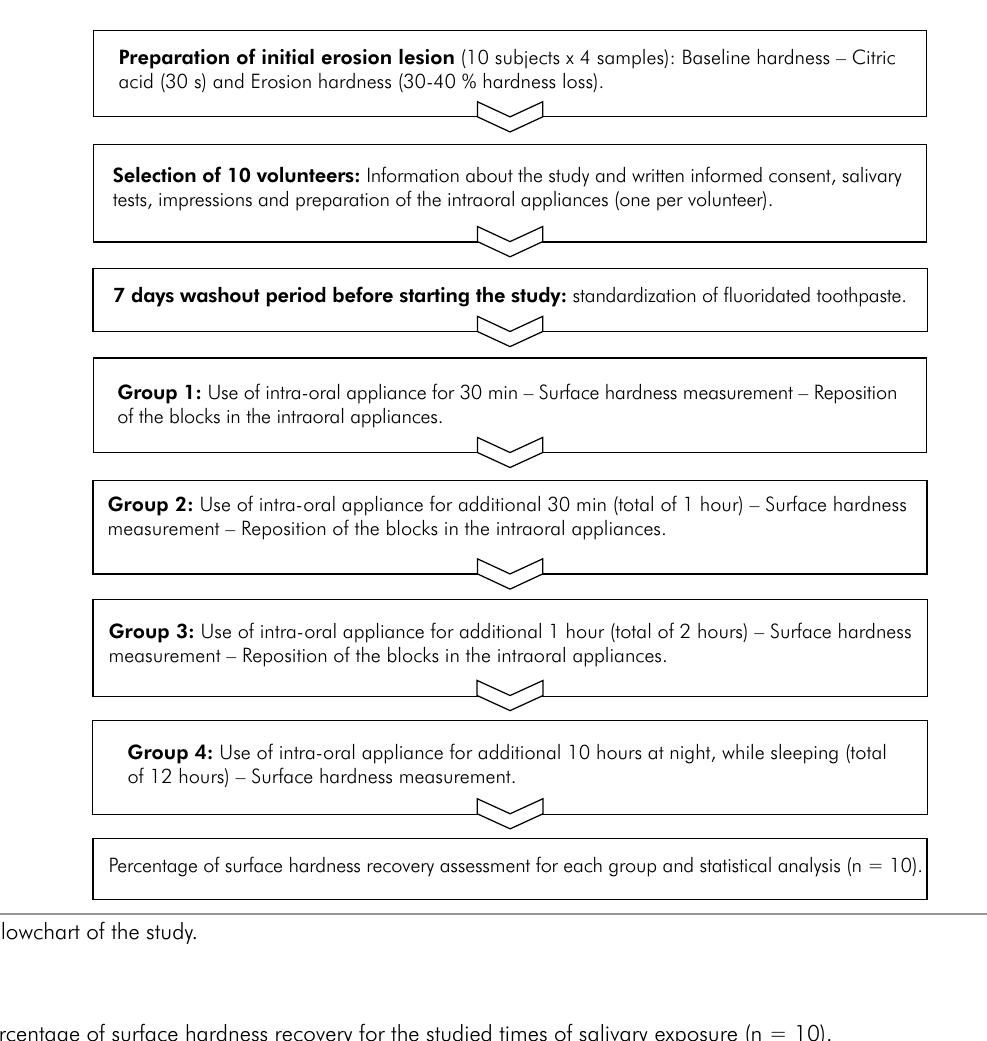
Table. Percentage of surface hardness recovery for the studied times of salivary exposure (n = 10). Period of salivary exposure